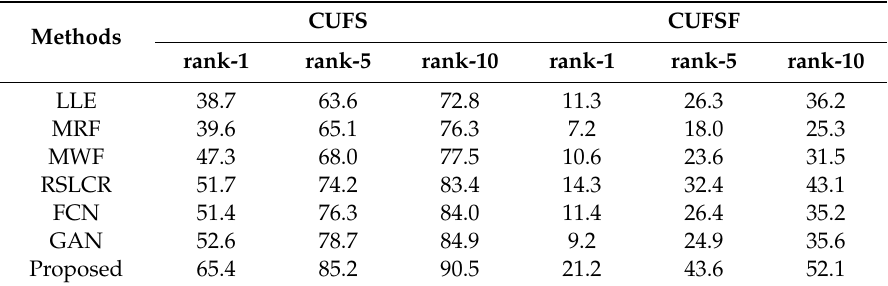
Table 2. Recognition accuracies (%) of FaceNet on the CUFS and CUFSF